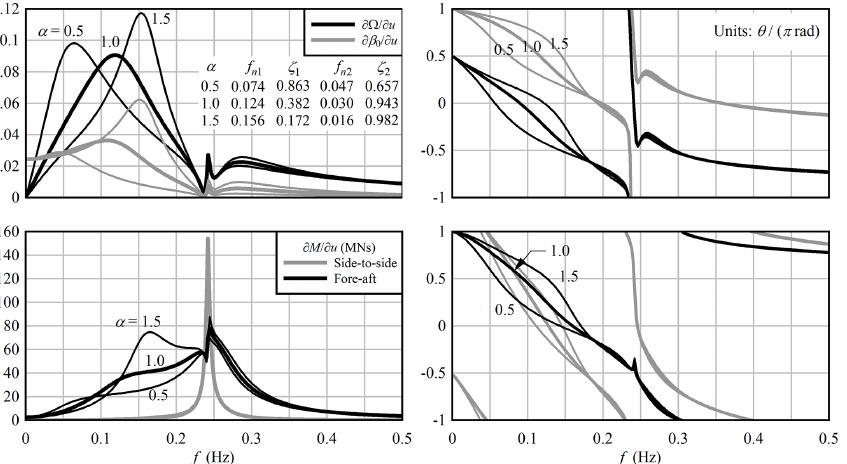
Figure 3. Magnitudes (left) and phases (right) of transfer functions between axial wind speed and blade pitch, rotor speed, and tower mud line bending moments. Three gains are shown: 0.5, 1.0 (thick lines), and 1.5 times the baseline gains from Fig. 1. The natural frequency (Hz) and damping ratio of the rotor speed control (1) and dynamic wake (2) modes are also shown, tabulated as a function of the gain multiple.